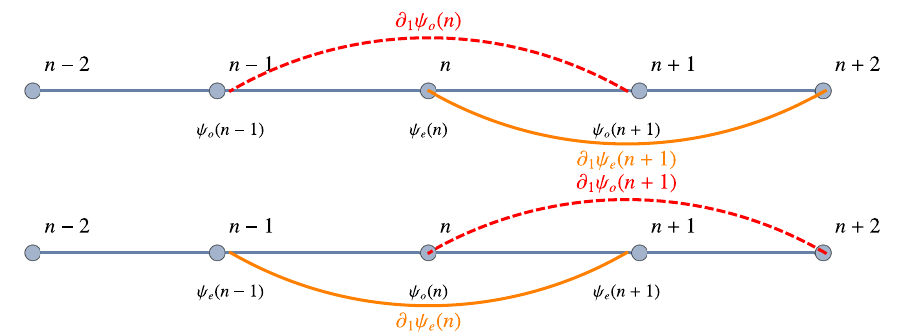
Figure 19. Spatial derivatives of one-component fermion fields on staggered lattice for even n (upper) and odd n (lower)